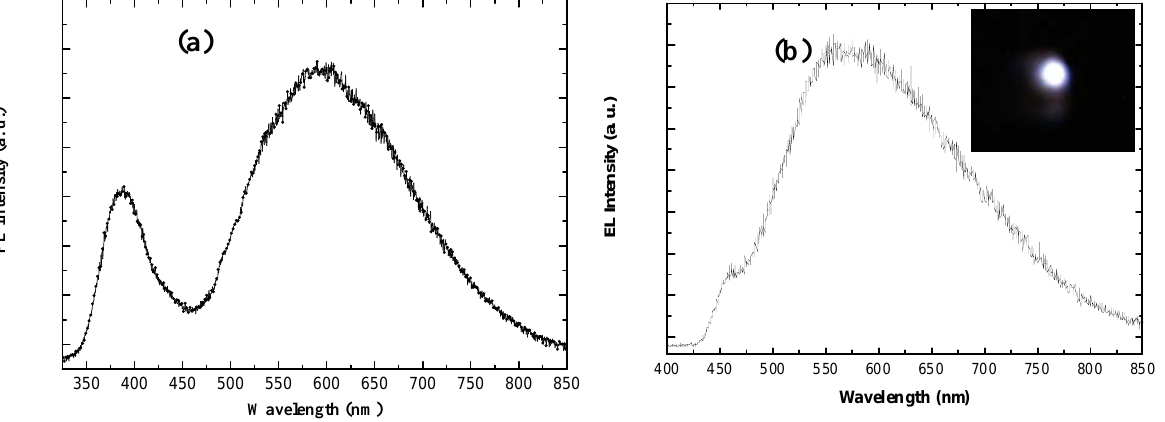
Figure 8. (a) Room temperature PL spectrum of ZnO nanotubes grown on GaN. (b) The corresponding electroluminescence spectrum obtained from the same ZnO nanotubes/p- GaN LED. The inset displays a digital photograph showing the light